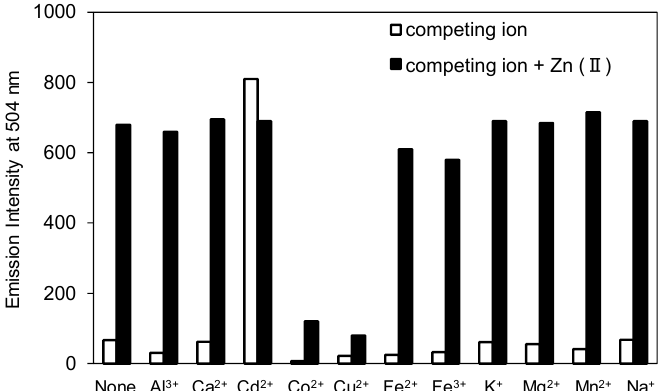
Figure 4. Competitive binding experiments of 5b , in which competing metal ions (10 − 3 M) and Zn 2+ (10 − 3 M) were added to 5b (10 − 5 M) in HEPES buffer (100 mM, 5% DMSO, pH = 7.4).